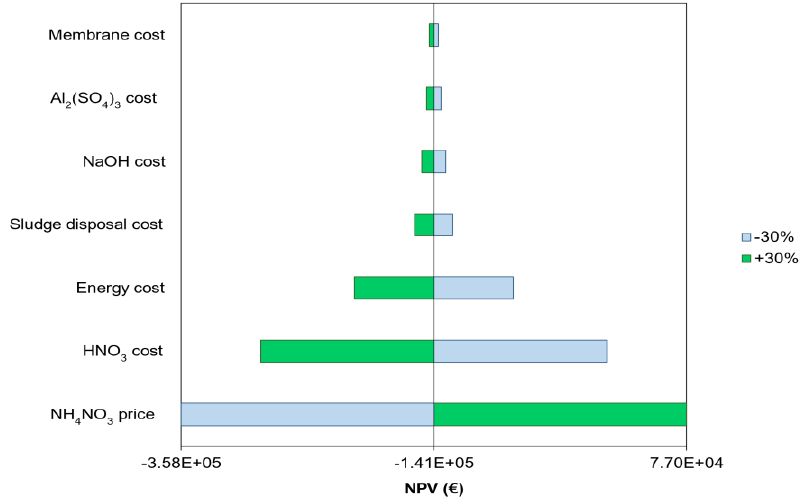
Figure 7. Sensitivity analysis for a ±30% variation of the main economic parameters .